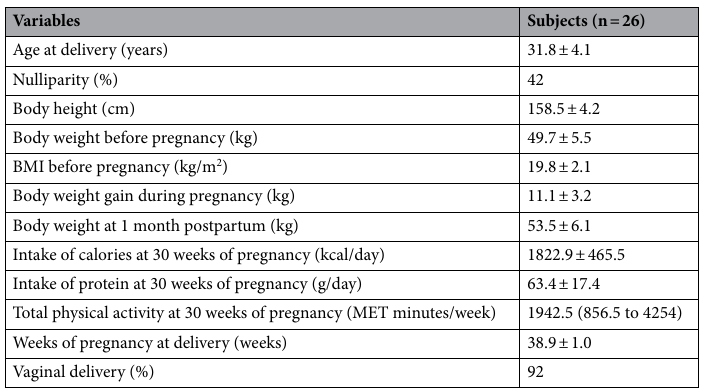
Table 1. Demographic characteristics in 26 women with normal pregnancy. Data are expressed as mean ± standard deviation, median (interquartile range), or n (%). BMI body mass index, METs metabolic